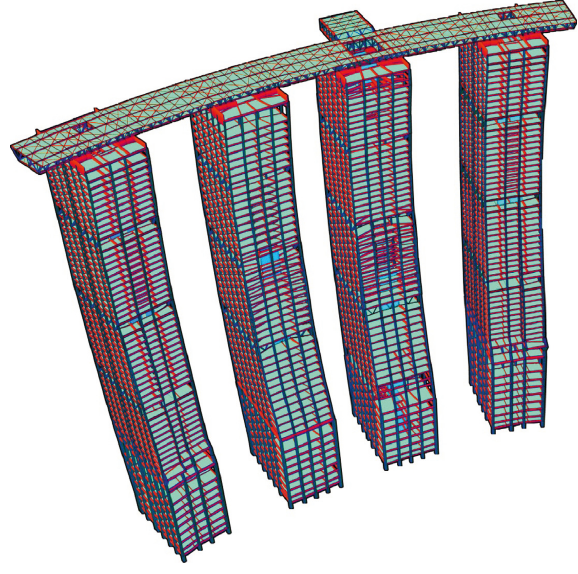
Figure 11: NosaCAD model.